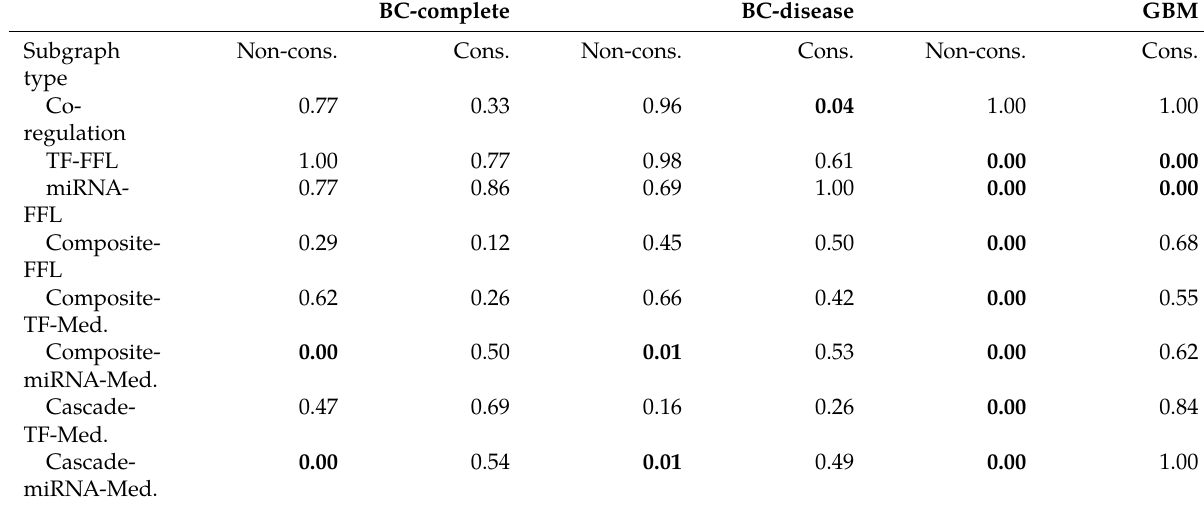
Table 2: p -values for different 3-node subgraphs in the considered networks when either the non-conserving or the con- serving randomization strategy is used.